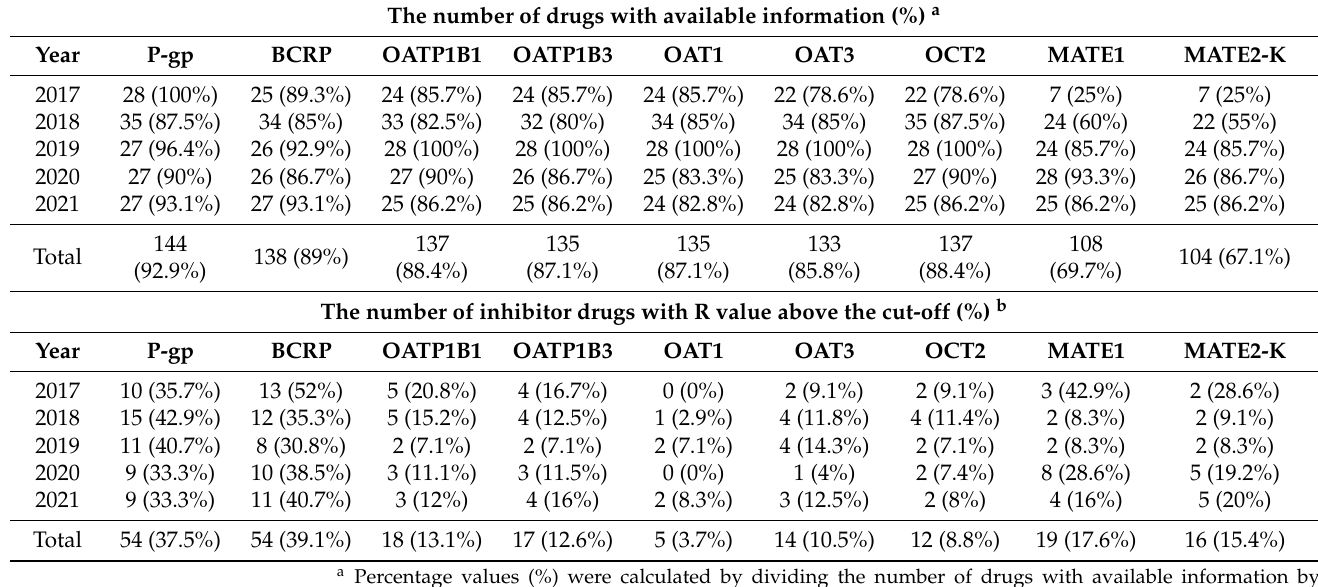
Table 2. Drugs with information available on transporter inhibitors and drugs that meet the pre- defined cut-off for potential clinical drug interactions.